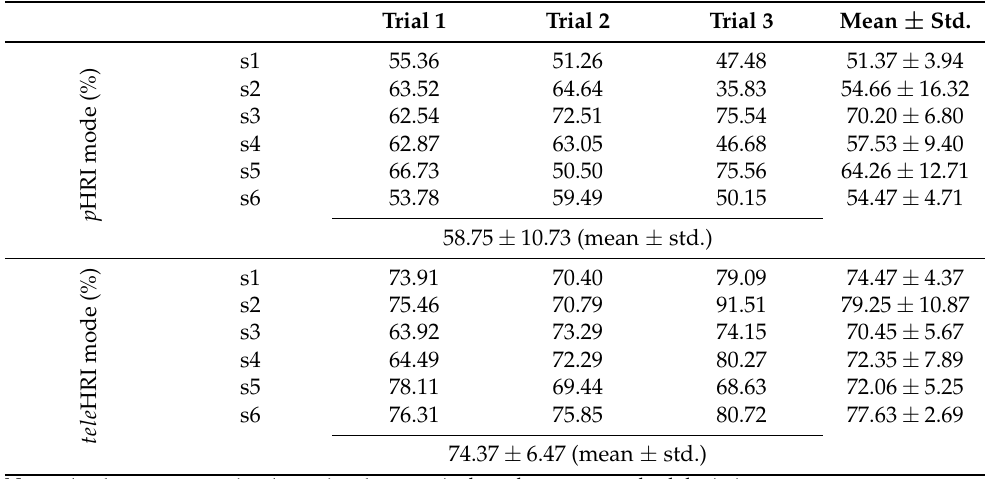
Table A3. Comparing the task performance on horizontal tissue surface under different feedback types in two modes when the proposed hybrid controller is implemented in Experiment 2a.